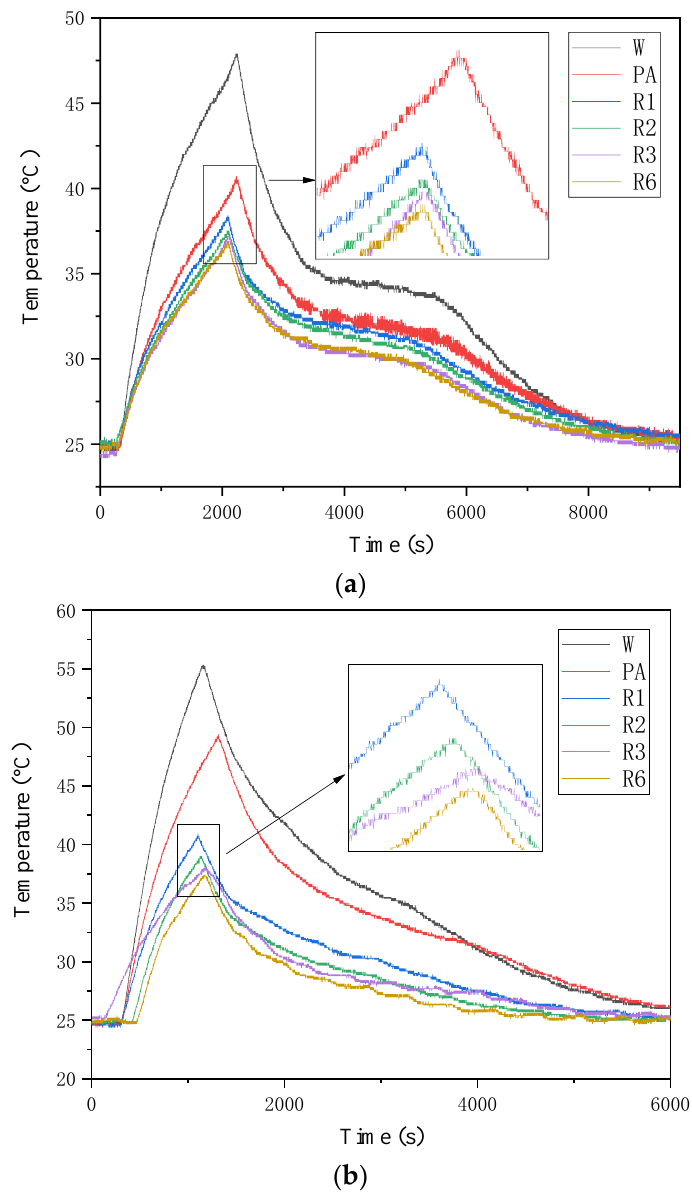
Figure 8. Cell temperature curve ( a ) 2 C ( b ) 3 C.